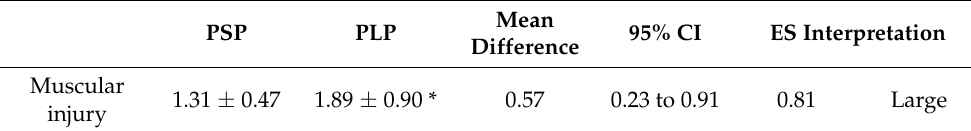
Table 4. Comparisons between Player Short Positivity (n = 35) and Player Long Positivity (n = 35) using the median-split technique for days of positivity. Values are given as mean ± SD (* p = 0.0014).